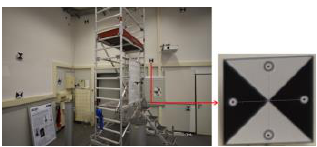
Figure 2. Calibration room (left) depiction of detected centroid of circles using sub-pixel target mode of the PhotoModeler software (right)